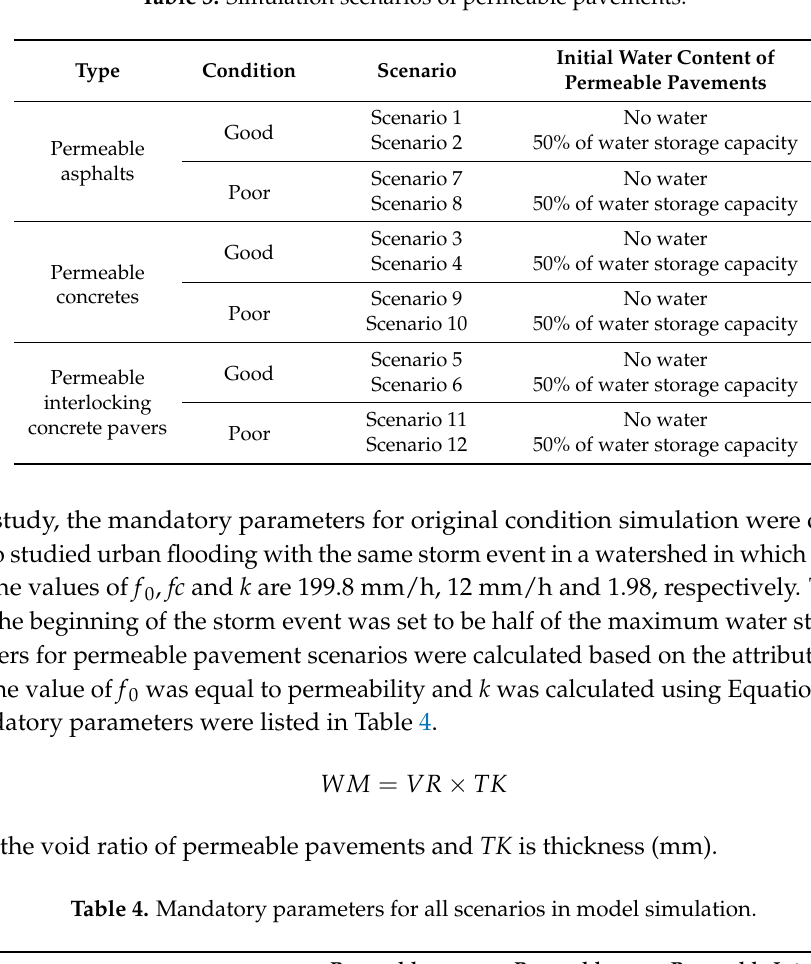
Table 3. Simulation scenarios of permeable pavements.